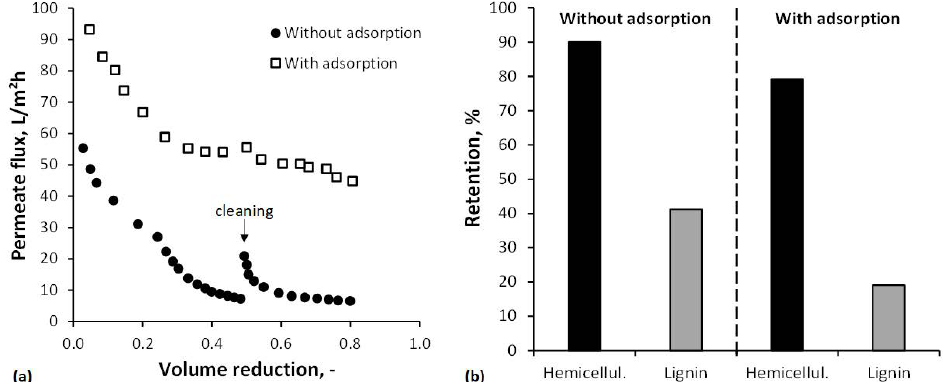
Figure 6. ( a ) Permeate flux and ( b ) retention for hemicellulose (oligomeric hemicellulose + monomeric xylose) and lignin during the ultrafiltration of beechwood hydrolyzate 2 with and without prior adsorption using the polymeric resin